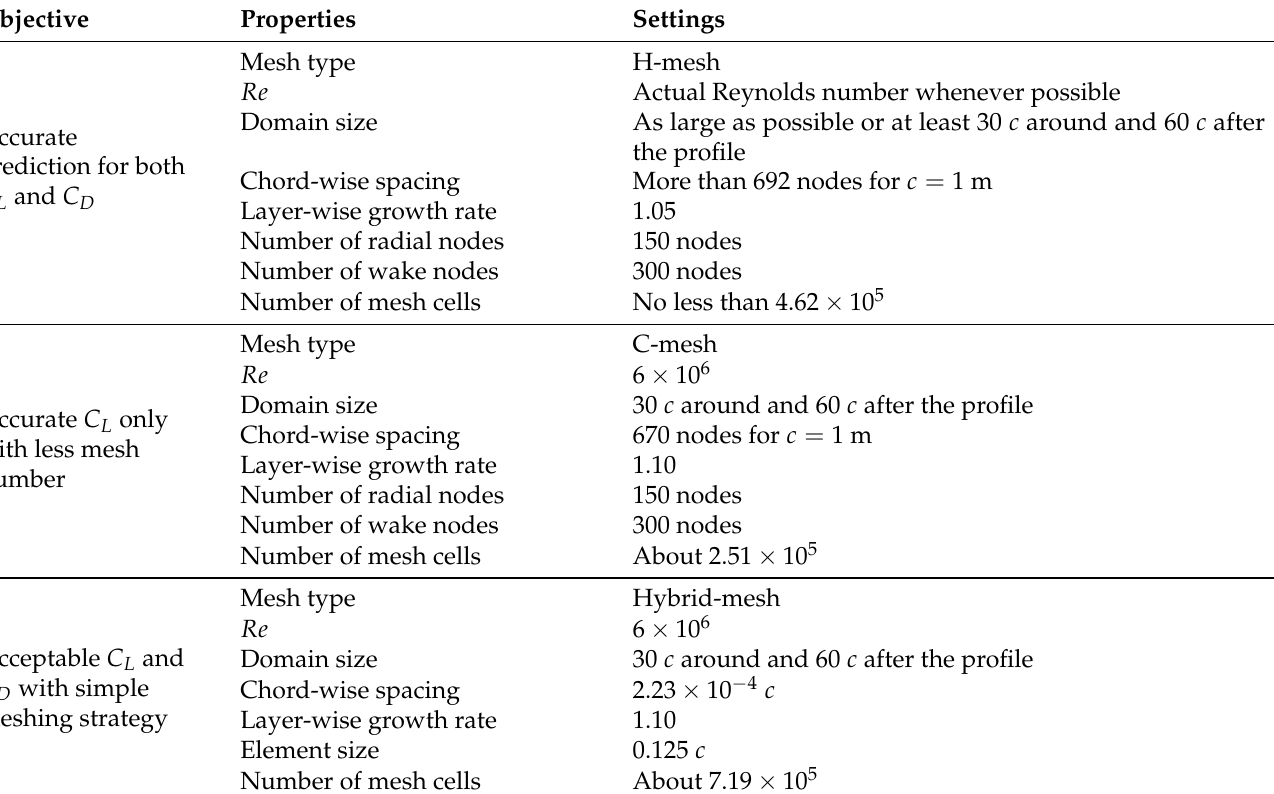
Table 30. Recommended mesh properties for different